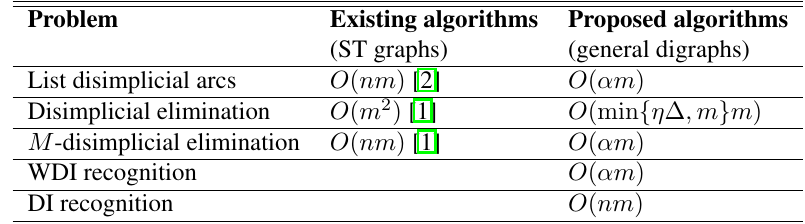
Tab. 1: Time complexities of the proposed algorithms for sparse digraphs; all the proposed algorithms require linear